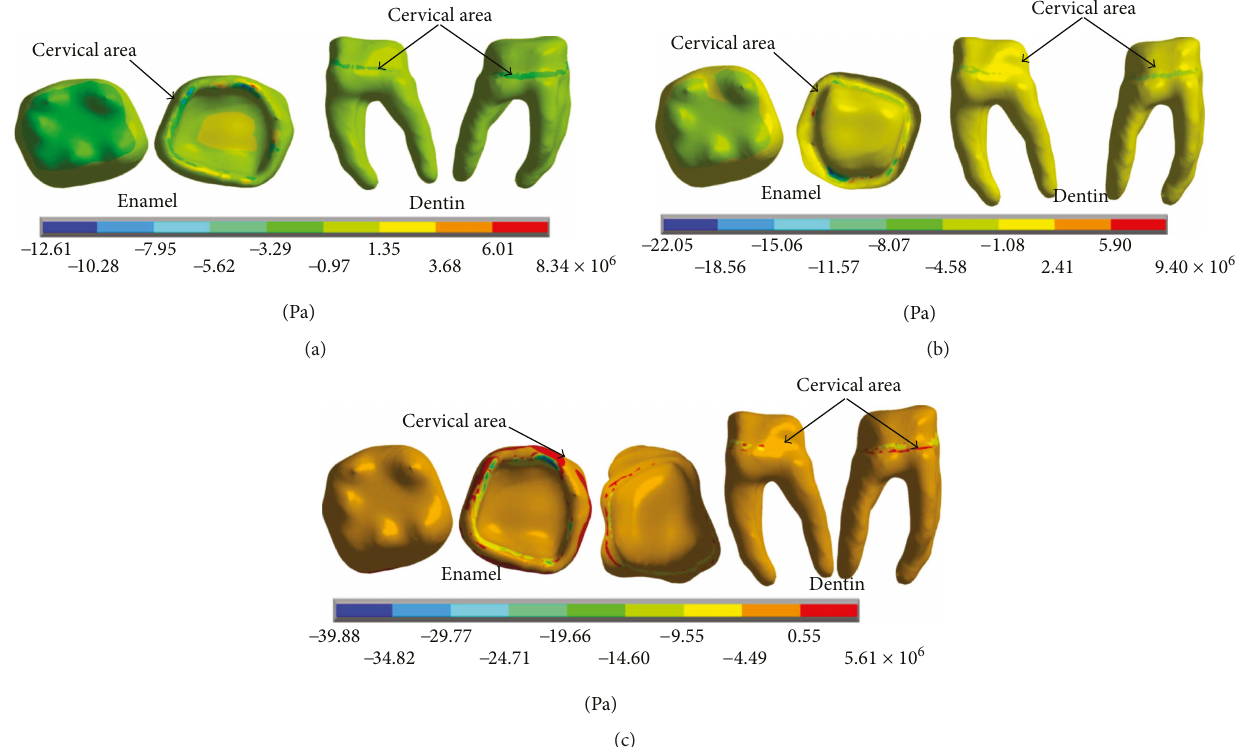
Figure 8: Nominal stress of the contact simulation. (a) x -axis. (b) y -axis. (c) z